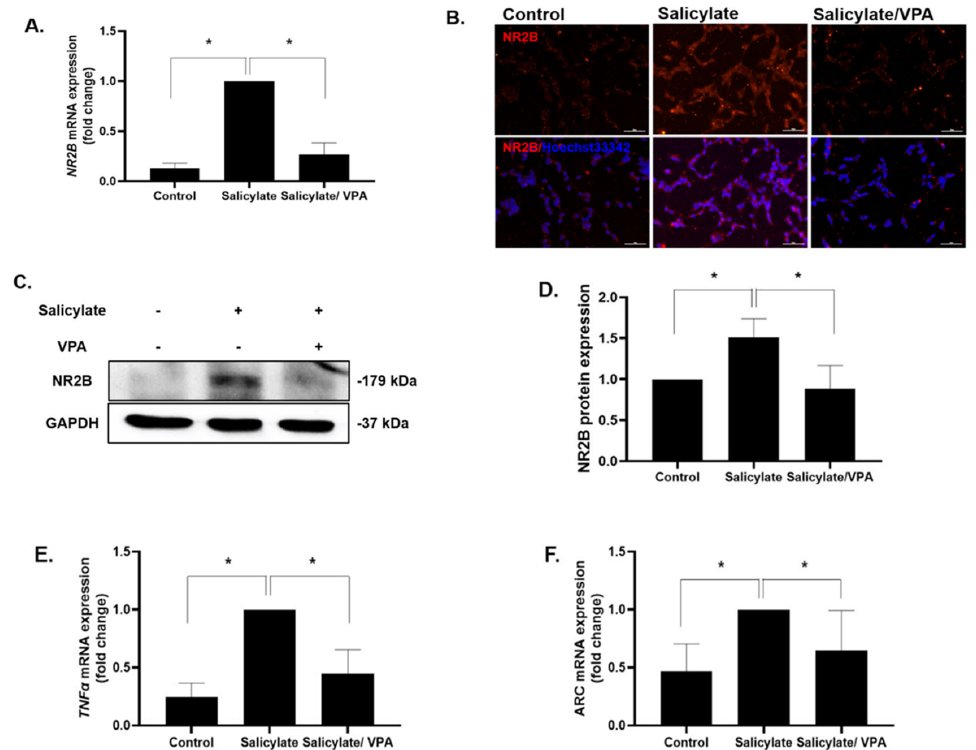
Figure 1. VPA reduces the expression of NR2B and related genes in neuronal SH ‐ SY5Y cell line ( A ) NR2B expression was increased in salicylate treated cells and significantly decreased in VPA ‐ pre ‐ treated neuronal differentiated SH ‐ SY5Y cells. Results were determined by quantitative PCR * p < 0.05, mean ± SD, n = 4), immunocytochemical staining ( B ), and immunoblot analysis (( C , D ); * p < 0.05, mean ± SD, n = 3). Quantitative PCR results of the inflammatory cytokine TNF α and immediate early gene ARC showed changes consistent with NR2B (( E , F ); * p < 0.05, mean ± SD, n = 6) One ‐ way ANOVA followed by post hoc Tukey test using GraphPad Prism 8.0.